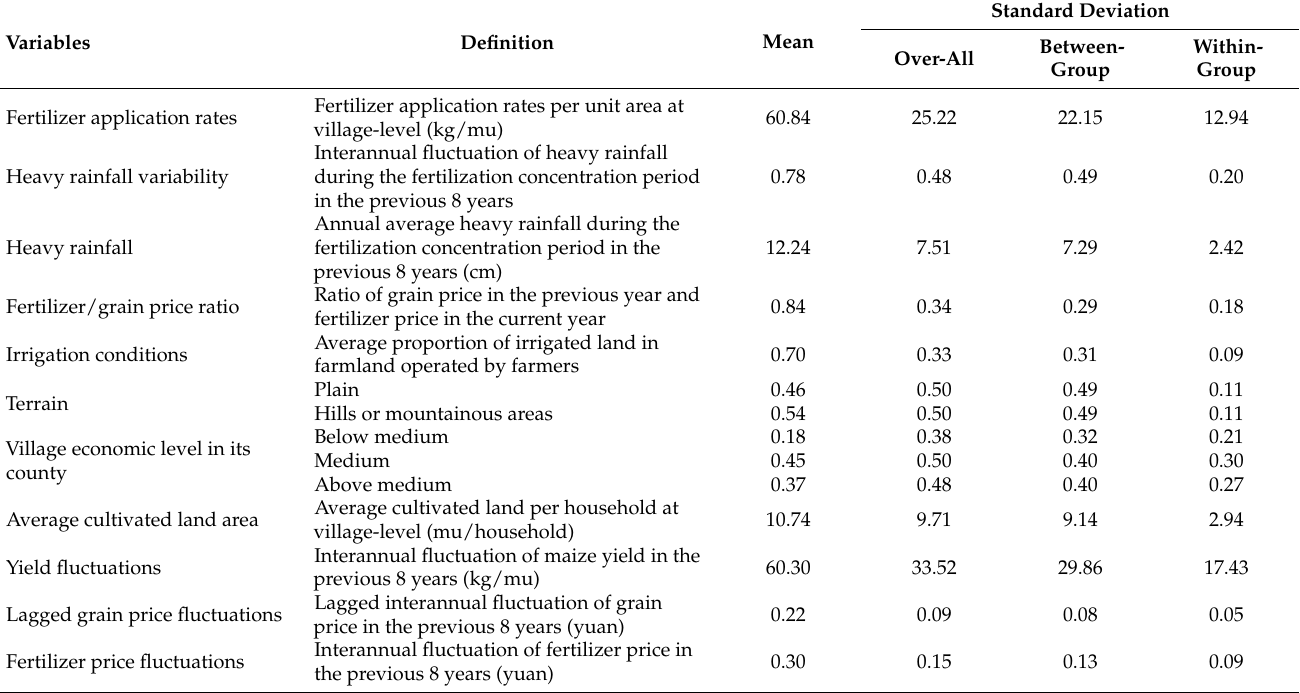
Table 1. Definitions and summary statistics of key variables.